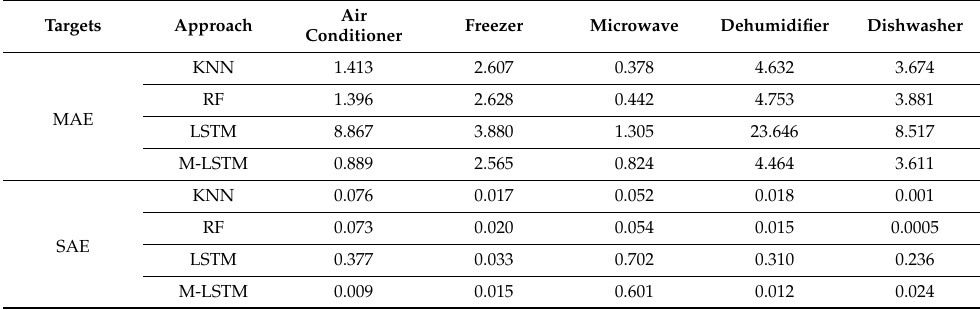
Table 3. Comparison of UK-DALE 5 household load decomposition assessment metrics.